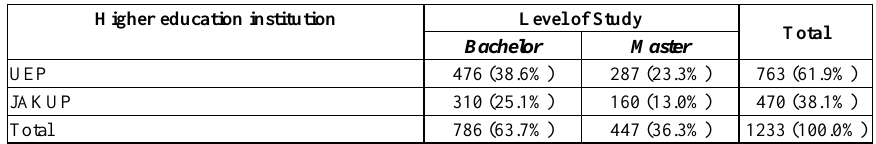
Table 1. Structure of the research sample – level of study (%)